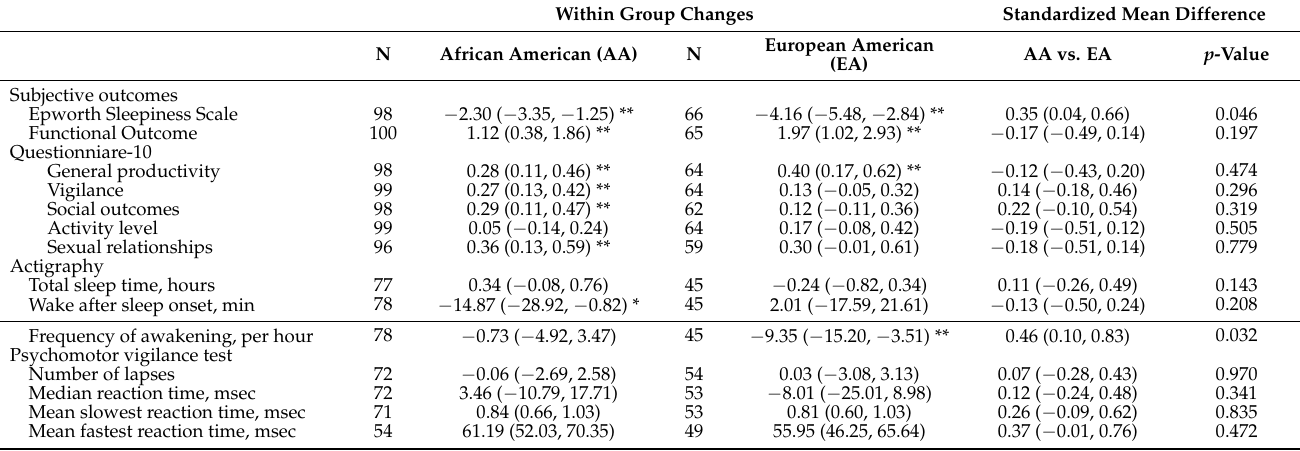
Table 3. Comparison of changes in outcomes after 3–4 months of PAP treatment.